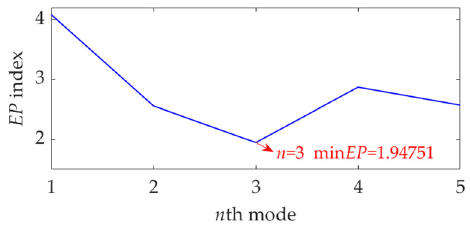
Figure 6. The EP index values of all modes.